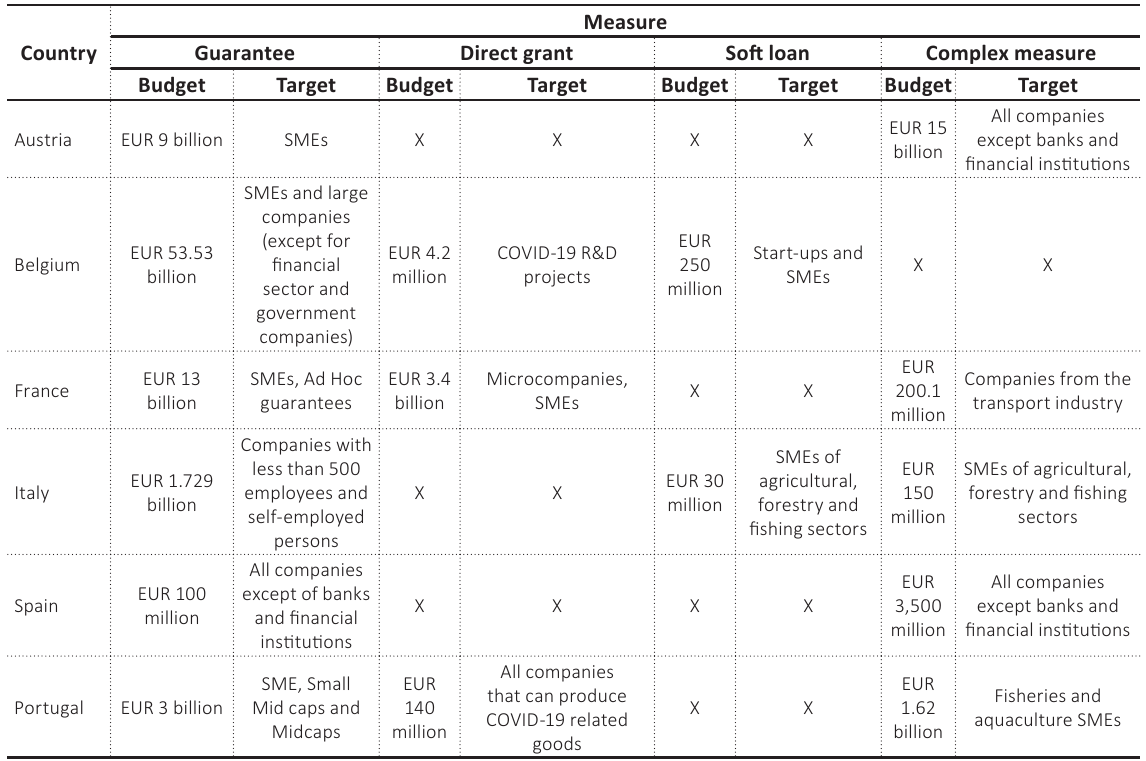
Table 4. Response of analyzed countries to